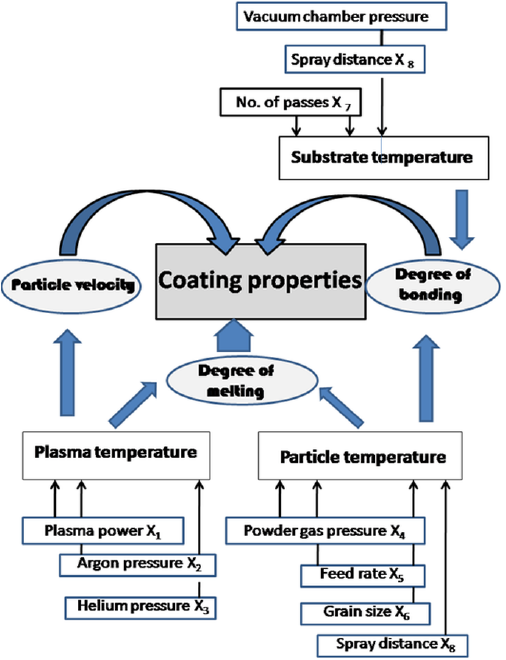
Figure 4. Development of coatings properties, showing a three-level hierarchy of plasma spray parameters, temperatures of plasma, particles and substrate, and particle velocity, degree of melting, and degree of bonding [34]. © With permission by Wiley-VCH, Weinheim, Germany.